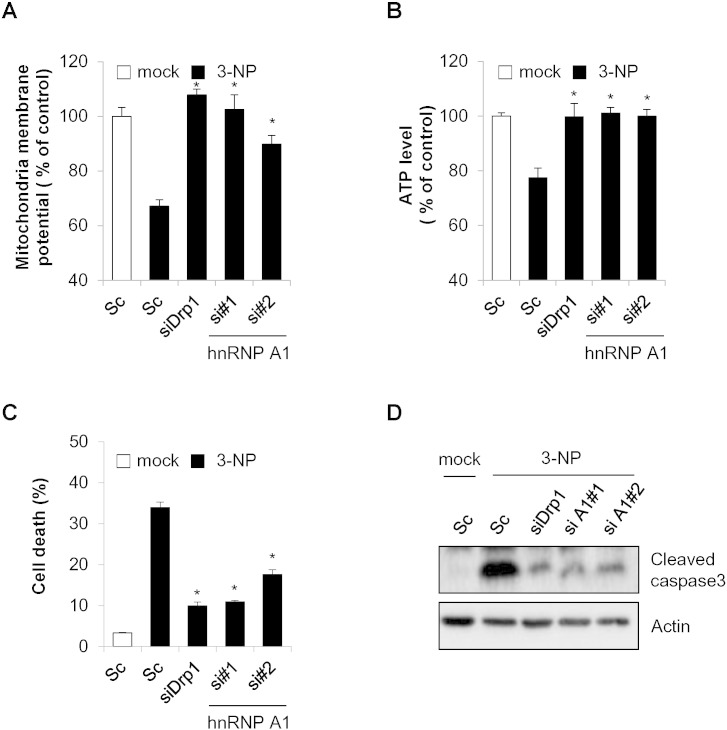
Down-regulation of hnRNP A1 inhibits 3-NP induced mitochondrial dysfunction and cell death.SK-N-MC cells were transfected with either control scrambled siRNA (Sc) or specific siRNA for hnRNP A1 (hnRNP A1 si#1, si#2) for 3 days. The cells were subjected to 3-NP (10 mM) treatment for 8 h. The siRNA for Drp1 (siDrp1) was used as a control. (A) Mitochondria membrane potential was measured using a TMRE assay system. (B) The intracellular ATP level was determined using an ATP bioluminescence assay system. (C and D) SK-N-MC cells transfected with either scrambled (Sc) or hnRNP A1 siRNA (si#1, si#2) for 3 days were treated with 3-NP (10 mM) for additional 24 h. (C) Cytotoxicity was measured by using a LDH activity assay system. (D) The cell death was assessed by Western blotting with a cleaved caspase-3 antibody. Data are represented as the mean ± SEM (n > 3, and *p < 0.05 value).